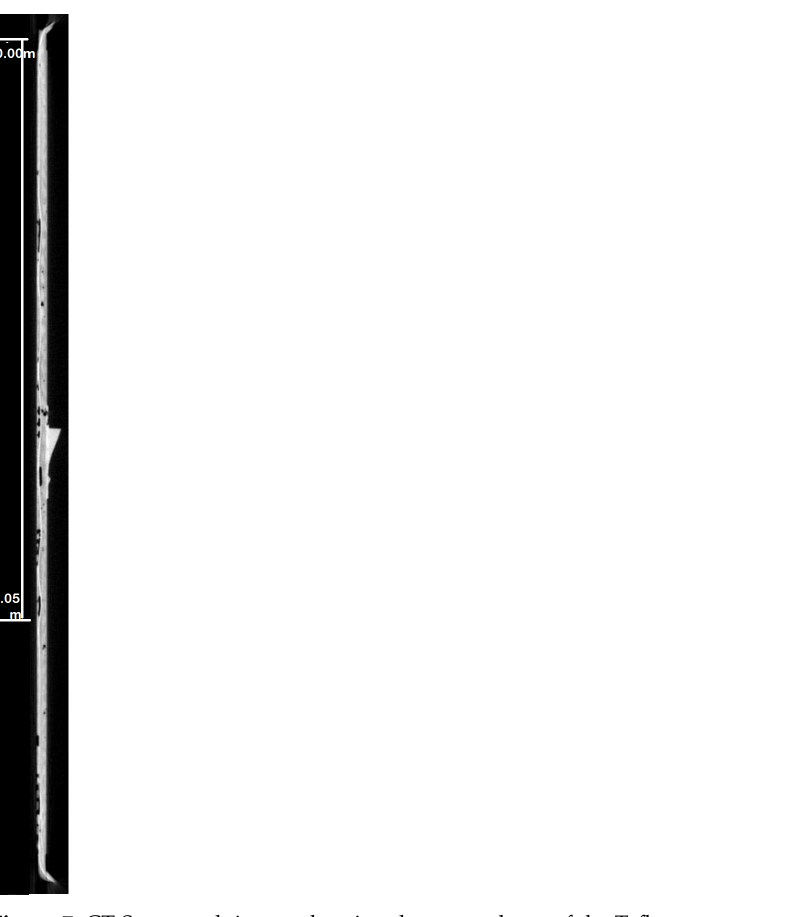
Figure 7. CT-Scan result image showing the wavy shape of the Teflon